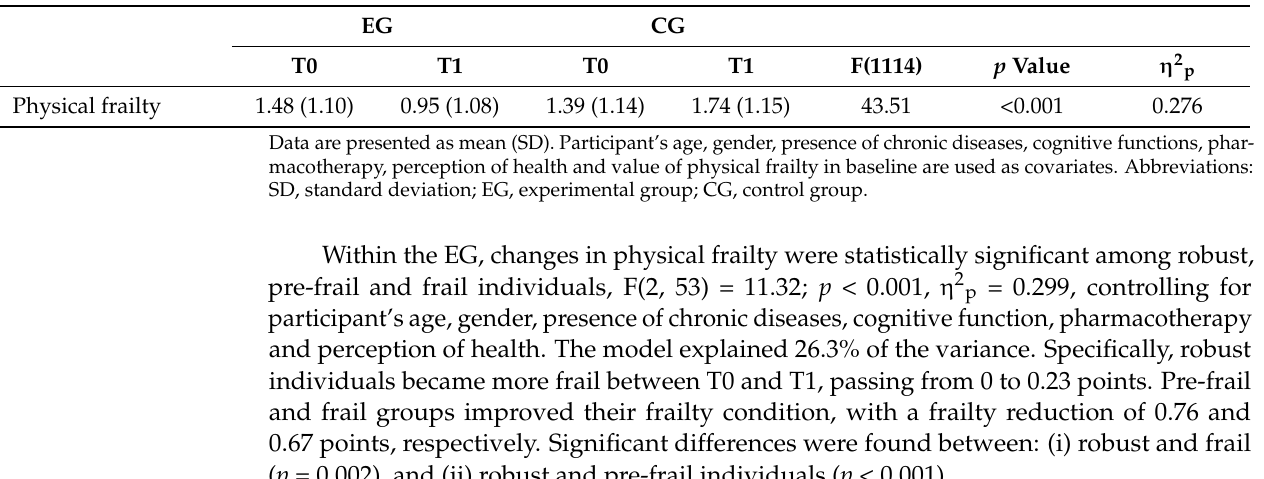
Table 4. Effects of training on physical frailty based on one-way ANCOVA ( n =